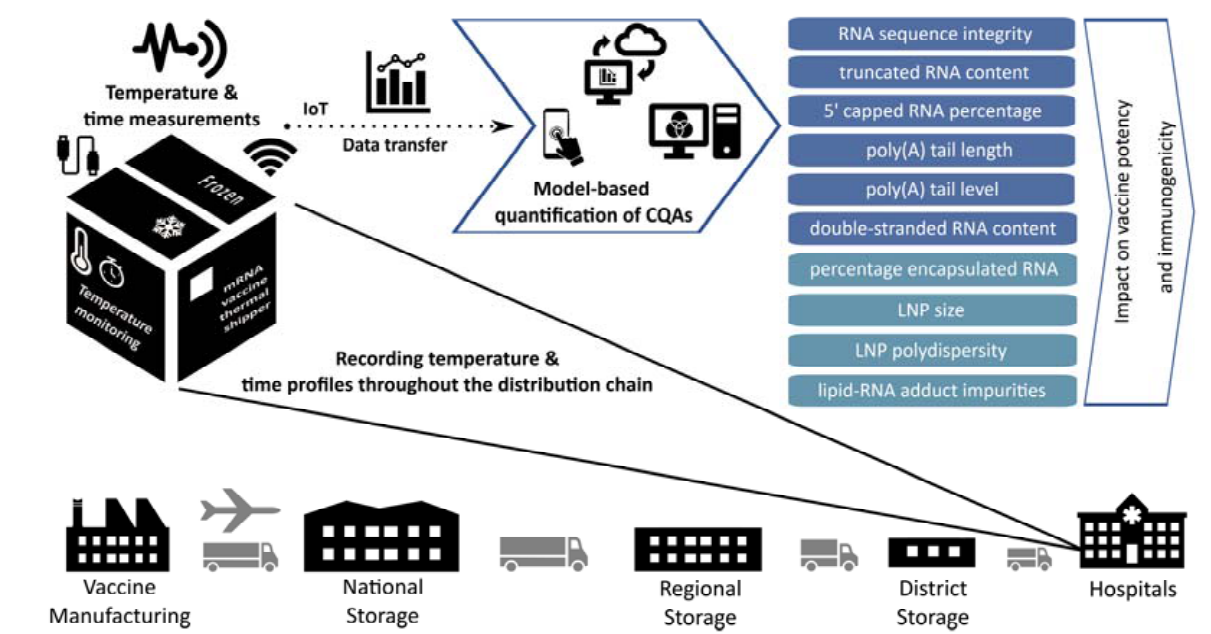
Figure 1. Illustration of the proposed model-based quantification of mRNA vaccine stability related CQAs and remaining shelf life. The temperature of COVID ‐ 19 mRNA vac ‐ cines is currently monitored throughout the distribution chain. Models can be devel ‐ oped, calibrated, validated and implemented to compute the values of stability related CQAs based on temperature and time measurements. These models can be cloud based and they could receive the data via the internet. After the results have been computed these can be returned to the user’s computer or mobile device (e.g., smartphone). These results will contain the quantitative values for each CQA and also the remaining shelf life.